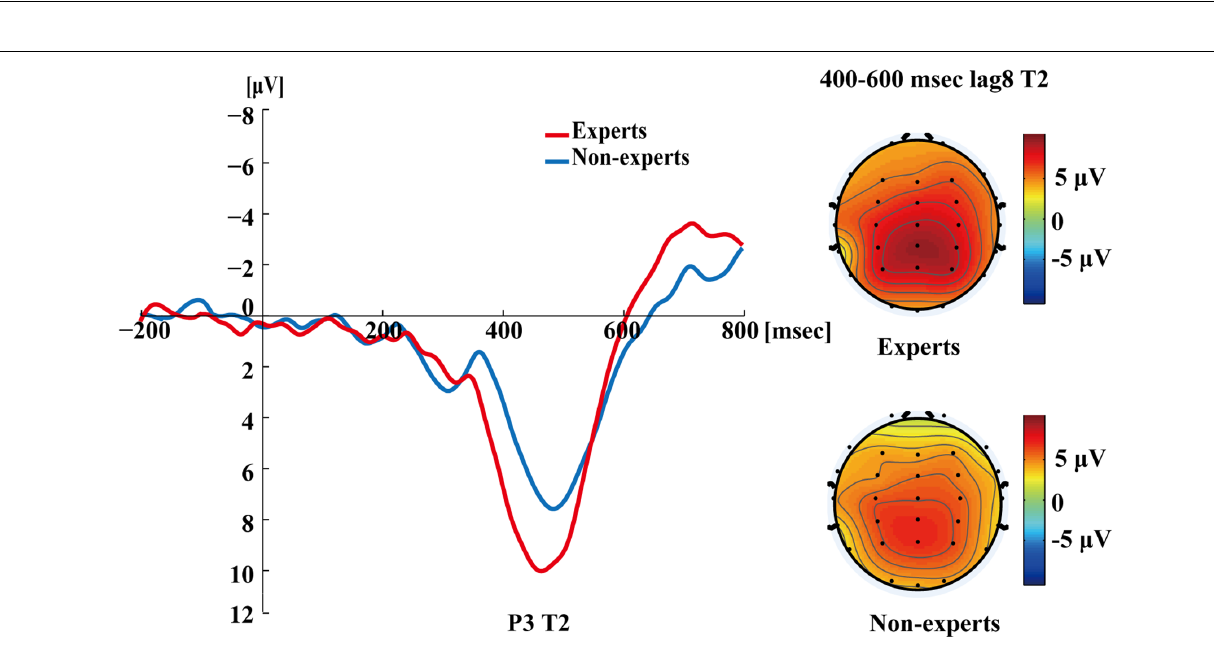
FIGURE 7 | Grand averages of the mean activation at Pz of the experts and the non-experts as a function of time for lag8 trials of correct T2 identification. ERPs were time locked to the onset of T2. The scalp distribution of 400–600 ms time windows for dual-target condition at lag8 for